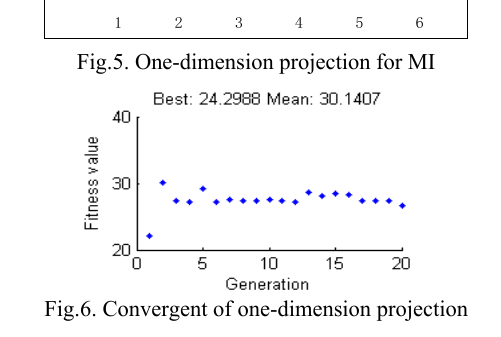
Fig.6. Convergent of one-dimension projection